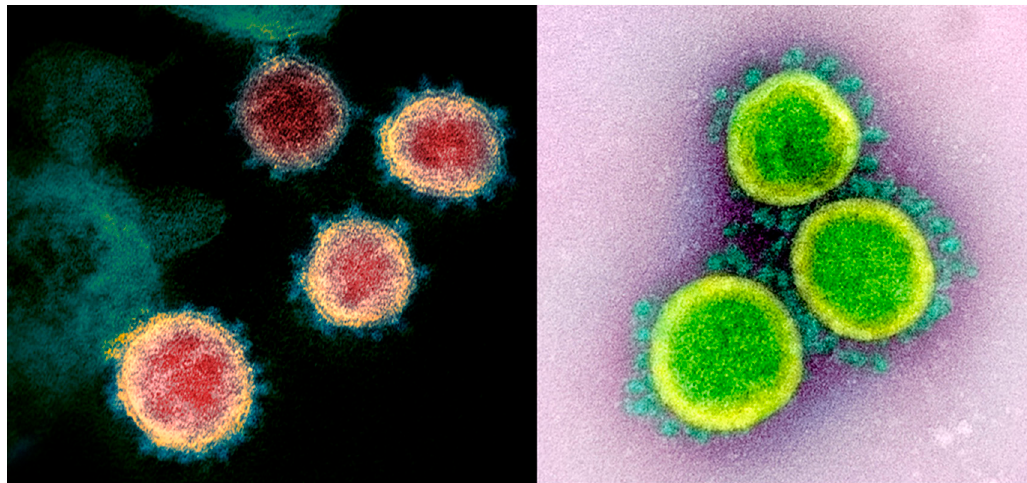
Figure 1. Images of SARS-CoV-2 obtained by transmission electron microscopy. The images show SARS-CoV-2 isolated from a patient in the United States. The virus particles shown are emerging from the surface of cells cultured in a laboratory. The spikes on the outer edge of the virus particles give coronaviruses their name. Both images were captured, colorized, and reproduced with permission courtesy of the National Institute of Allergy and Infectious Diseases’ Rocky Mountain Laboratories in Hamilton, MT, USA [23].